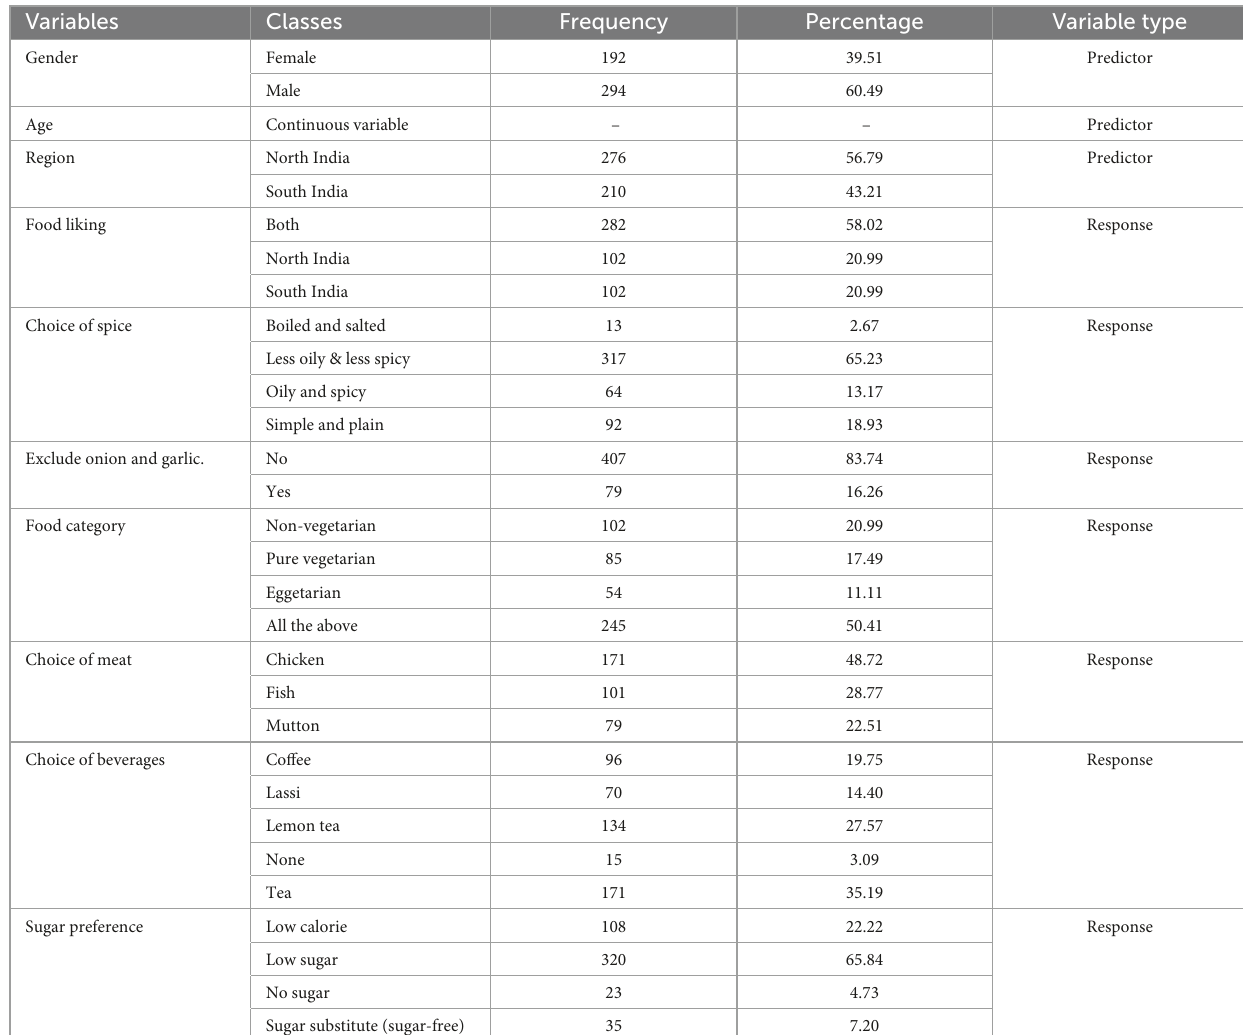
TABLE 1 Study variables and distribution of